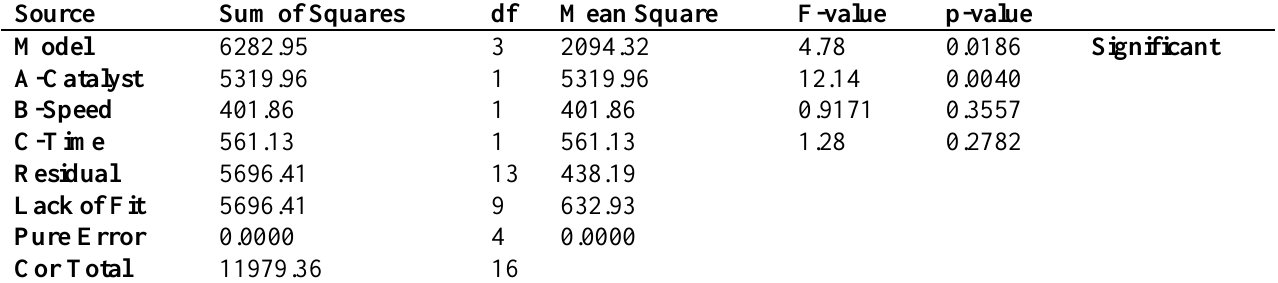
Table 3: ANOVA Table for the “Yield” linear model.